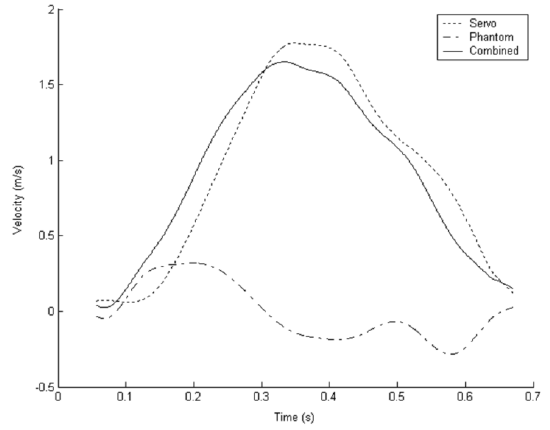
Figure 6. Averaged velocity profile for the reciprocal tapping task using the PD controller.